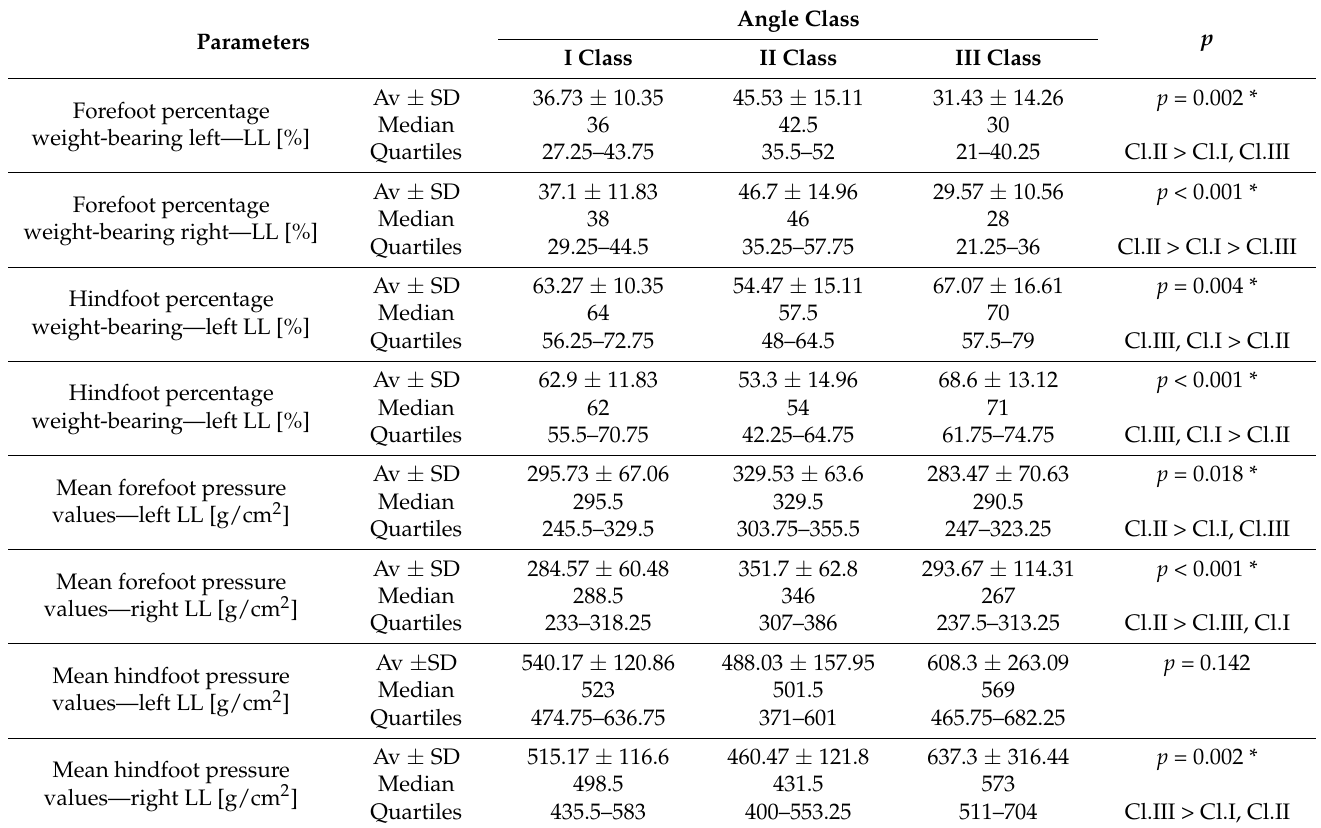
Table 2. Foot load distribution in groups with Angle Class I, II and